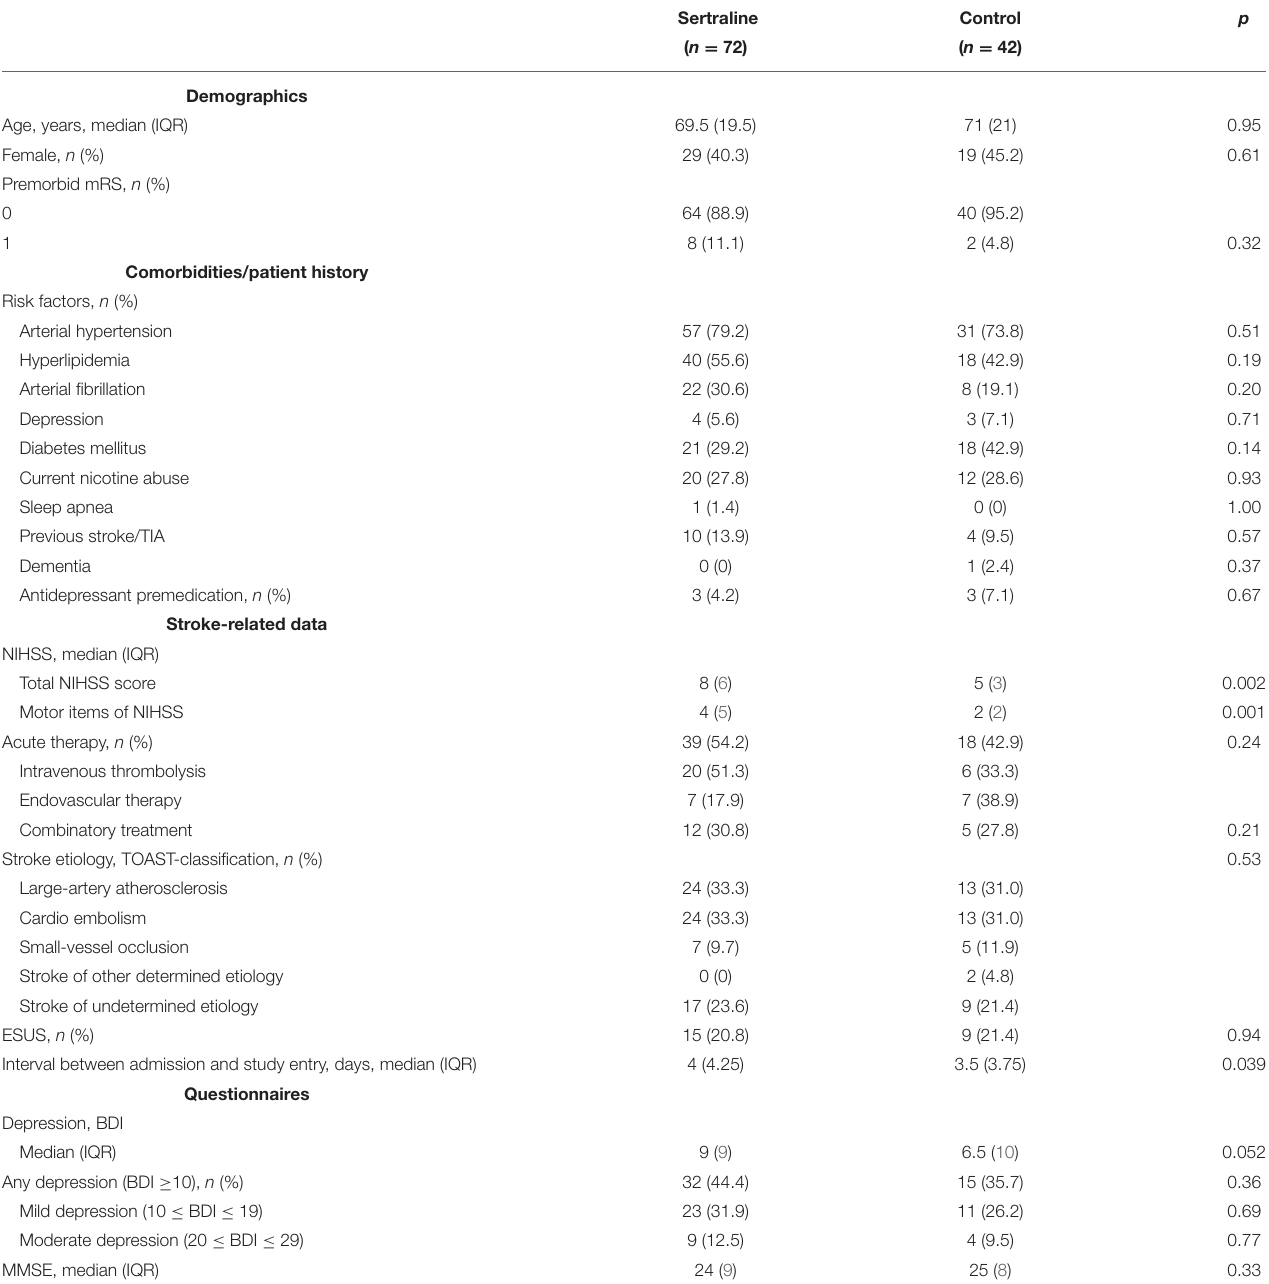
TABLE 1 | Baseline characteristics of the study cohort.